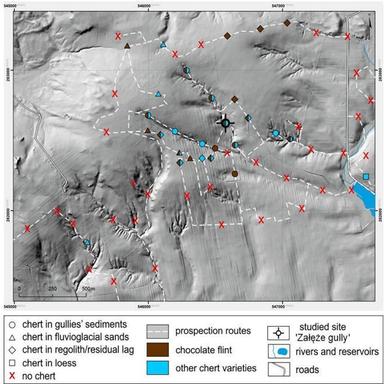
The prospection routes, the occurrence of chert varieties, and their geomorphological contexts according to field reconnaissance survey in the studied area indicated by a frame "c" in. The presented data is a compilation of new data and data from M. Krajcarz's survey initiated in 2007.